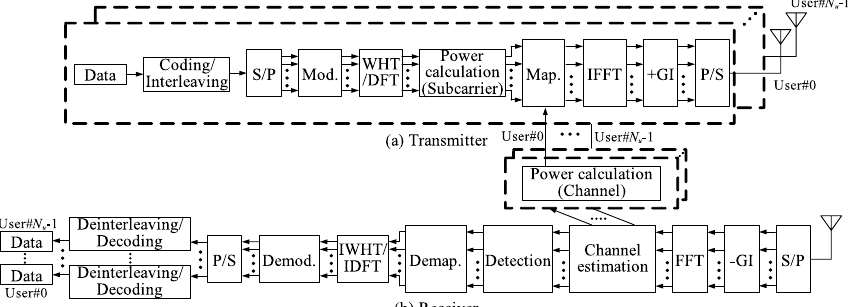
Fig. 1 Block diagram of the proposed